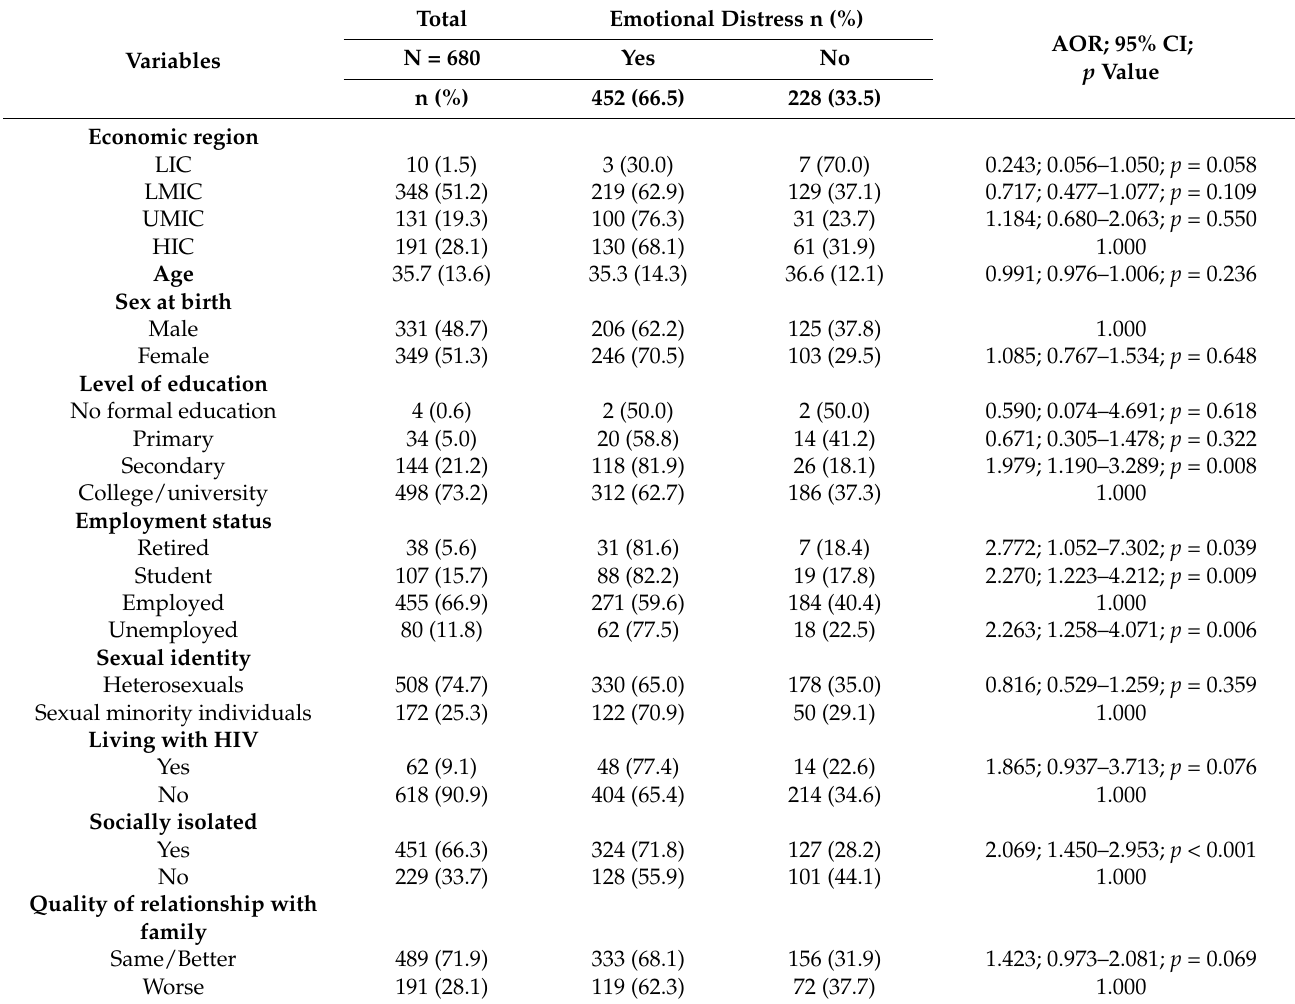
Table 2. Multivariate logistic regression analysis to determine factors associated with emotional distress for people who used psychoactive drugs during the first wave of the COVID-19 pandemic (N =